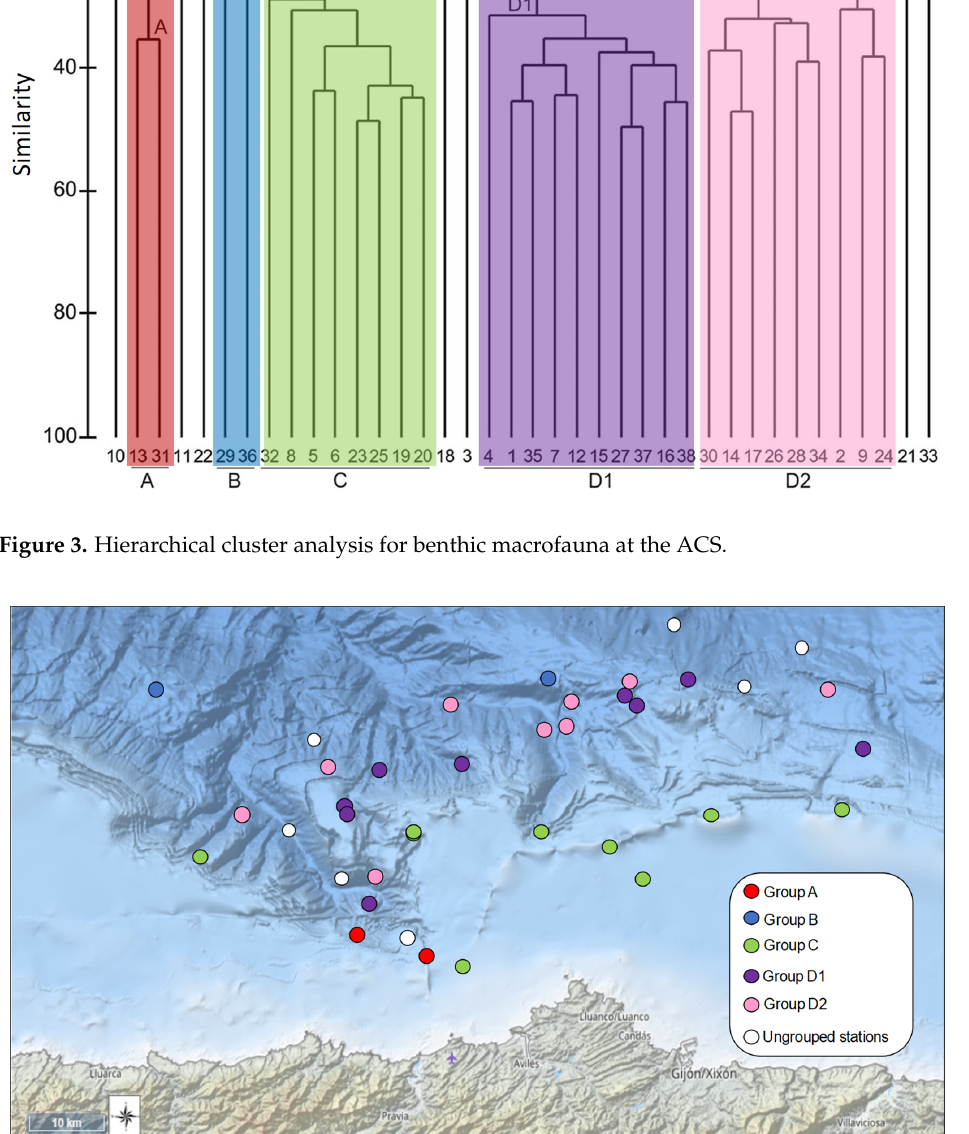
Figure 5. Non-metric multidimensional scaling (nMDS) ordination of sampling sites showing groups determined by cluster analysis, and ordination of sites with values of some environmental variables superimposed (depth; fine sand; mud). Table 2. Abiotic and biotic characteristics of the main infaunal macrobenthic assemblages dis- criminated by the multivariate analysis of abundance data. Depth (m) Q 50 (mm)